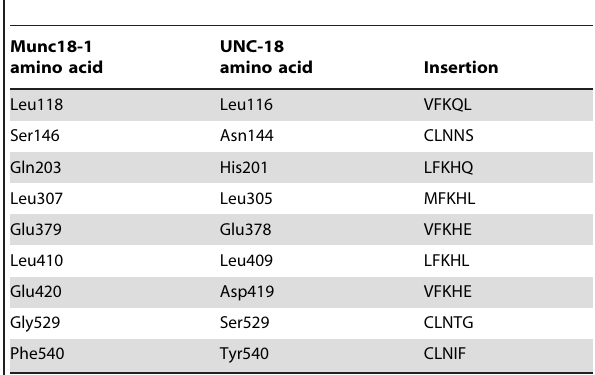
Table 1. Munc18-1 insertion mutations as defined by the last unchanged amino acid, the orthologous residue in Caenorhabditis elegans and the exact 5 amino acid insertion.